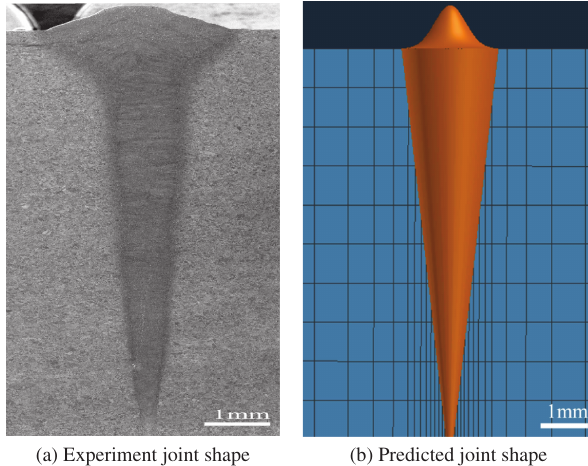
determined by the actual EBW joint geometry parameters.